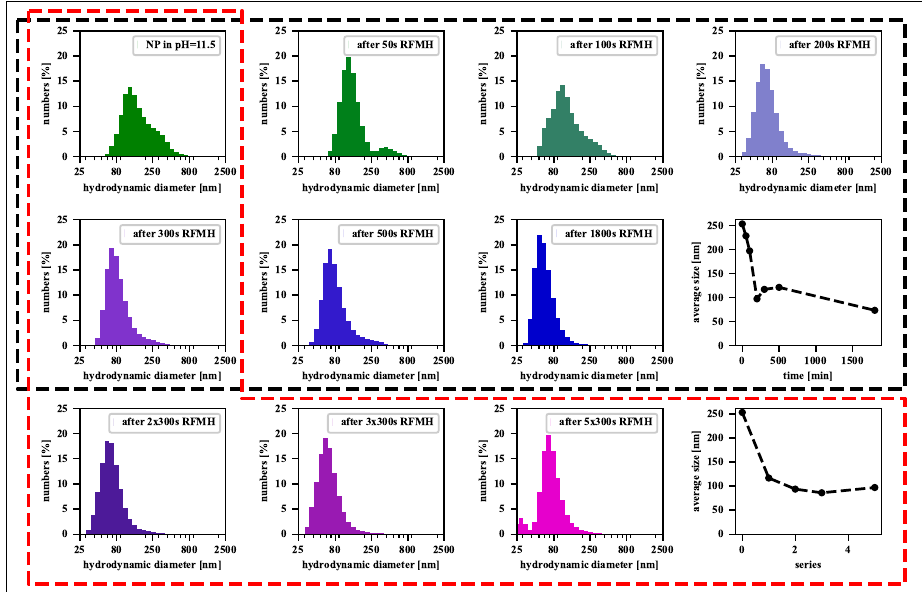
Figure 5. The histograms of the size distribution of NPs in the pH = 11.5 solution for samples taken from the upper part of the Eppendorf tube: (the panels surrounded by a black dashed line) during the 1800-s RFMH process and (the panels surrounded by a red dashed line) during a series of 300 s processes, where a single process was applied 1, 2, 3 and 5 times. Each of the panel group is supplemented with the plot showing how the average particle size changes with